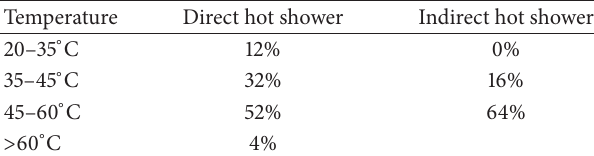
Table 3: Temperature of hot shower.